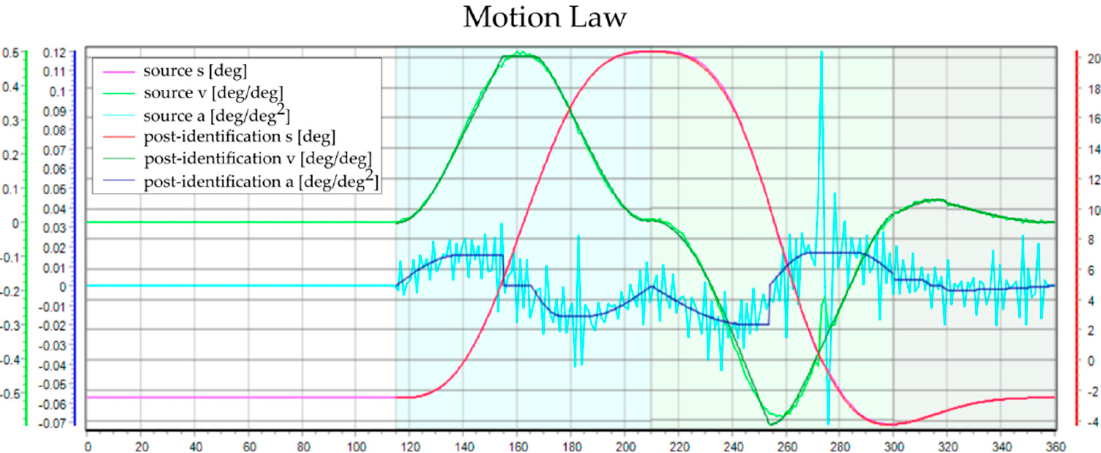
Figure 10. Comparison between the experimental law of motion (light blue) and modified trapezoidal laws for each phase (with equal coefficients values) as the starting point of the identification procedure (red: displacement; green: velocity; blue: acceleration).